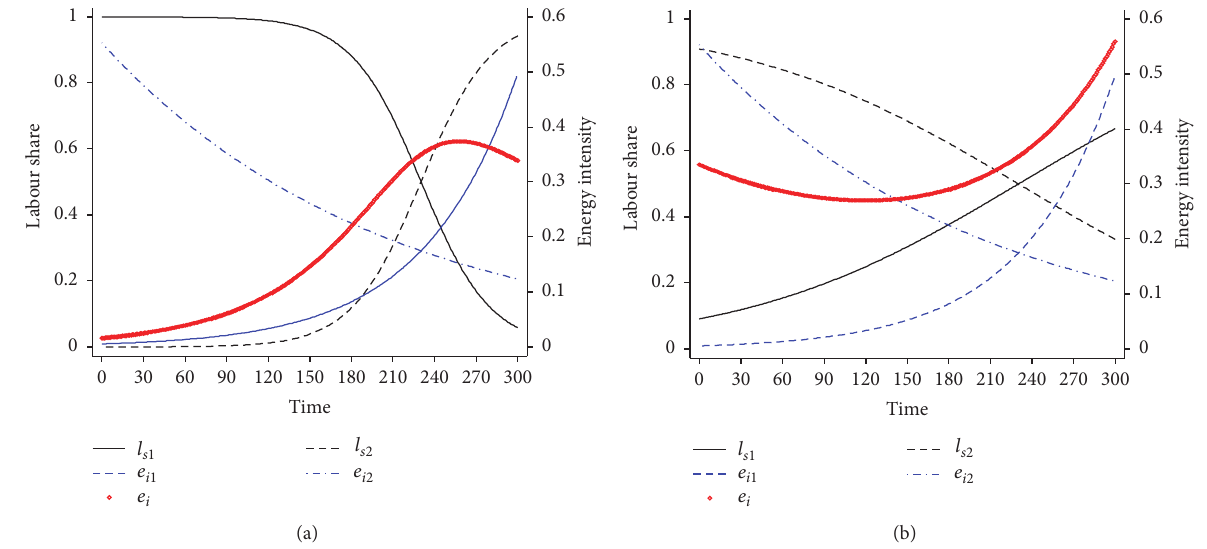
Figure 4: Nonmonotonic change of economy-wide energy intensity with medium energy technological growth rate, (a) 𝜀 = 3 and (b) 𝜀 = 0.5